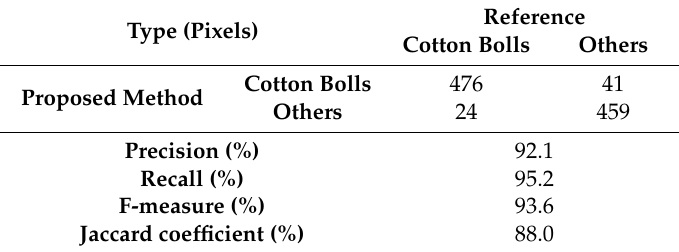
Table 3. Cotton boll extraction accuracy in the north site.